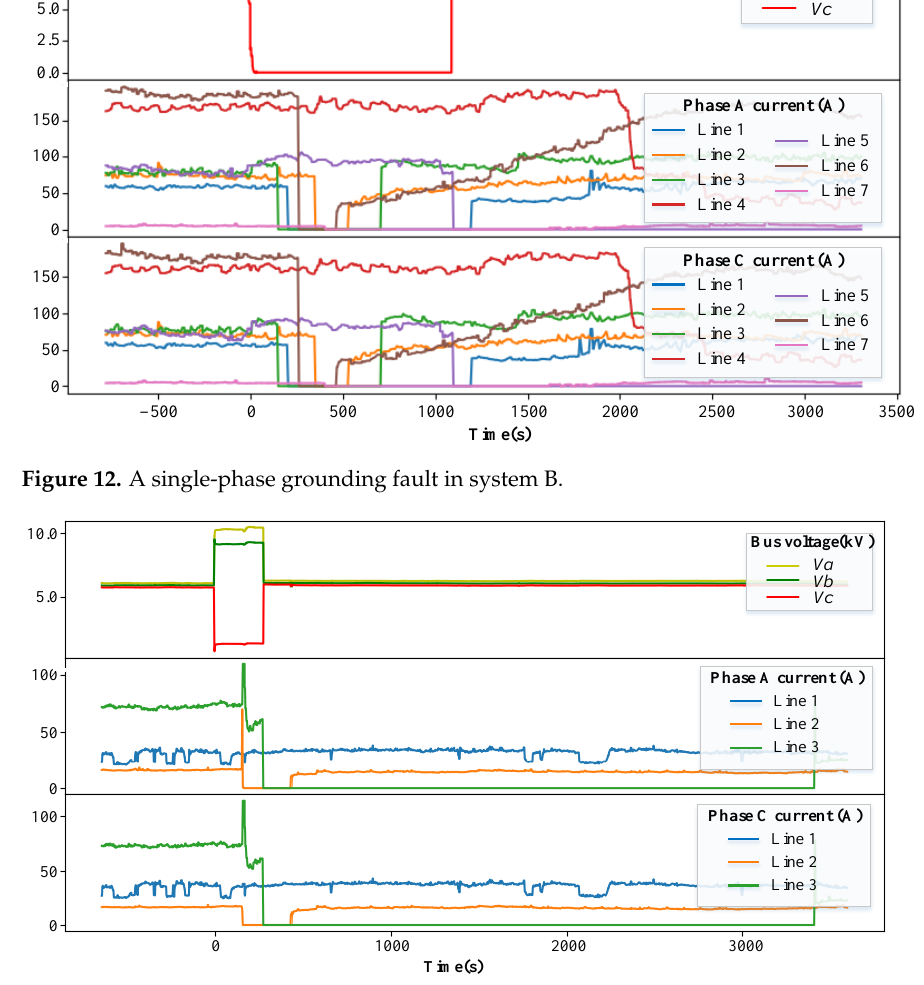
Figure 13. A single-phase grounded fault in system A .